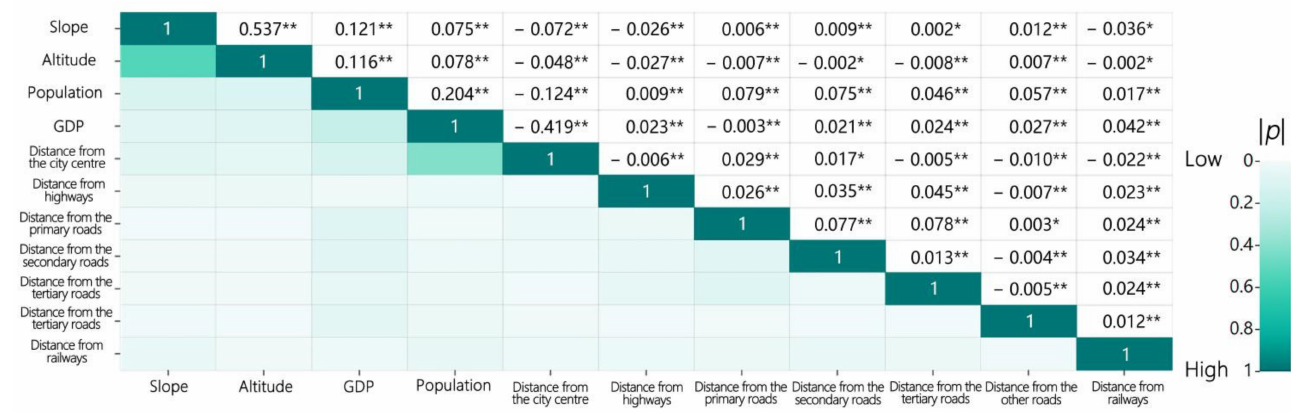
Figure 2. Correlation evaluation of driving factors. * and ** indicate significant